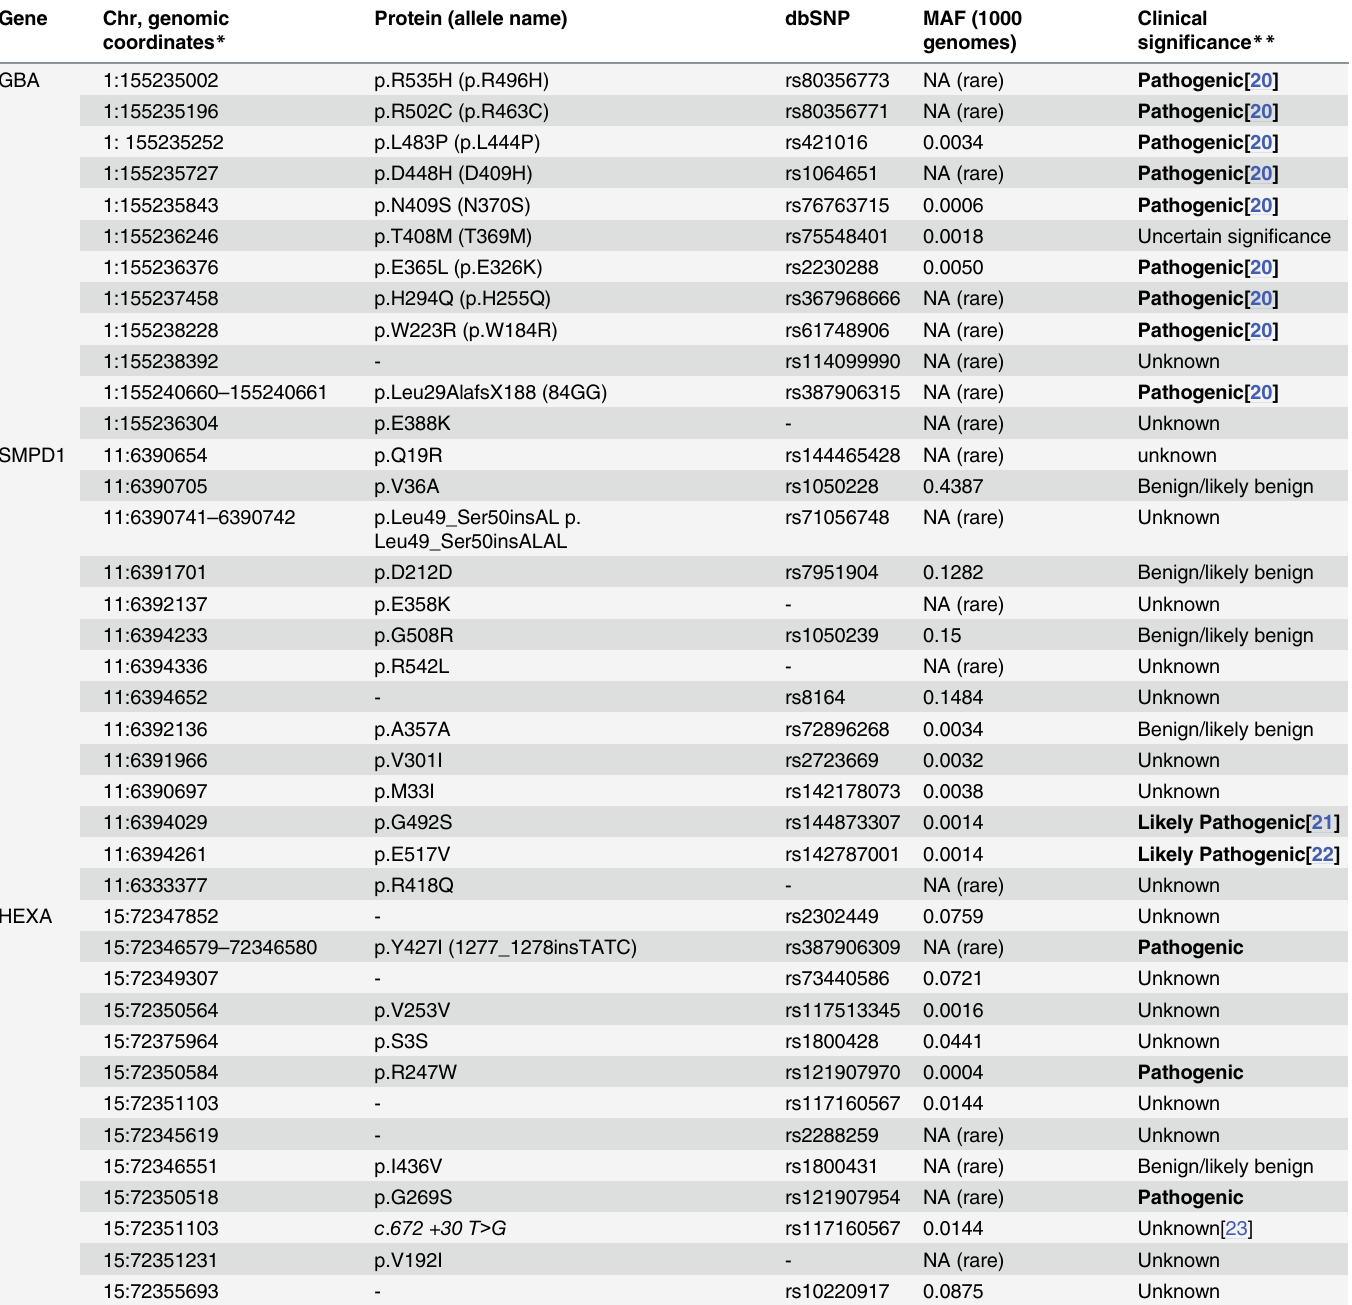
Table 2. Variants identified in brain autopsy